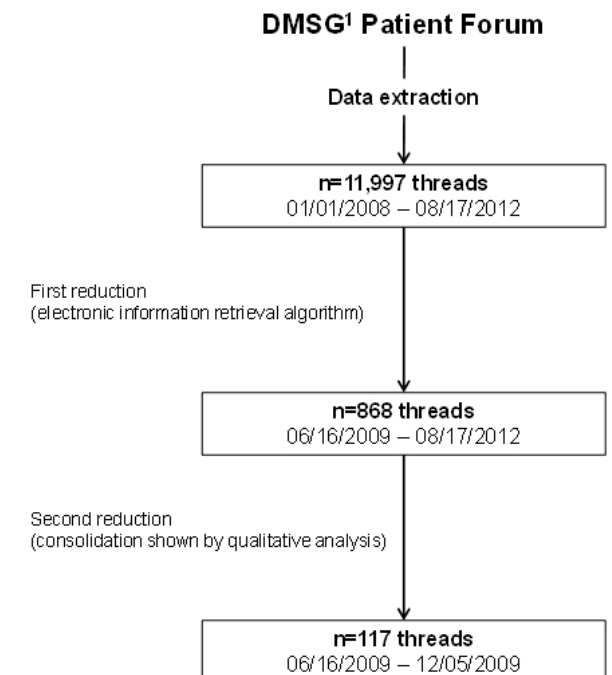
Figure 1. Flowchart of the data extraction and reduction